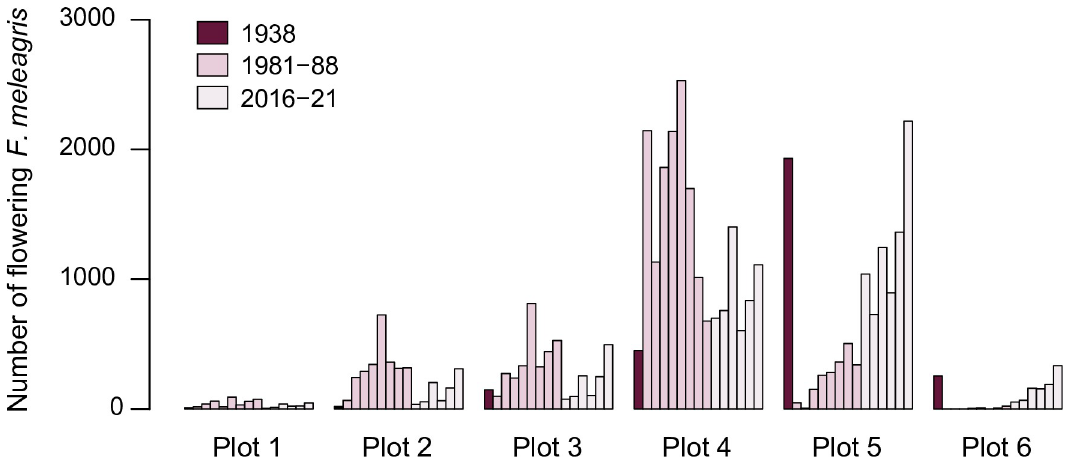
Fig 8. Number of flowering Fritillaria meleagris in each of six plots (10 m × 10 m) along Profile 1 (Fig 1) on Kungsa¨ngen, in 1938, 1981–1988 and 2016–2021. Plots 1–4 are in the drier part of the meadow (elevation ~1.8 m a.s.l.), and plots 5–6 in the wettest part of the range of F . meleagris (1.6 and 1.3 m a.s.l.,